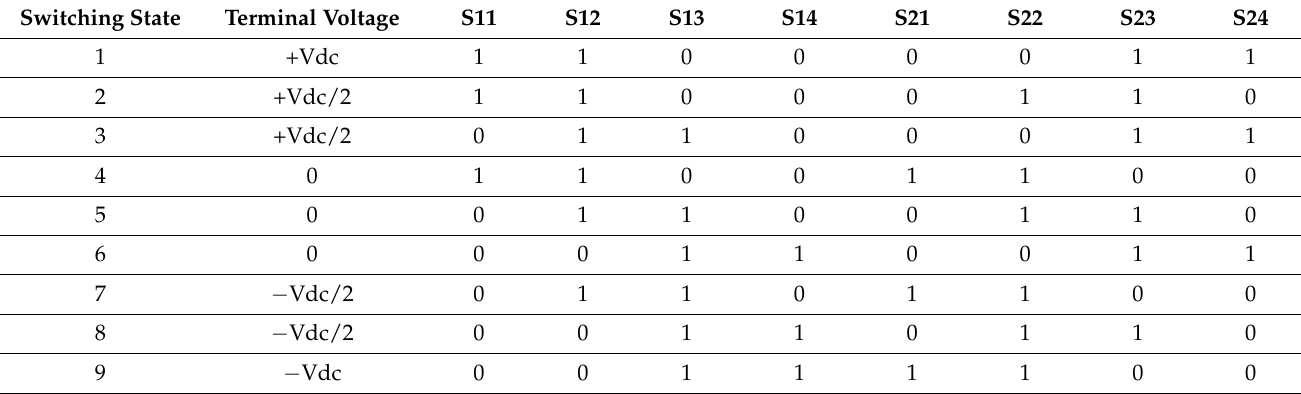
Table 1. Switching patterns corresponding to each voltage level.